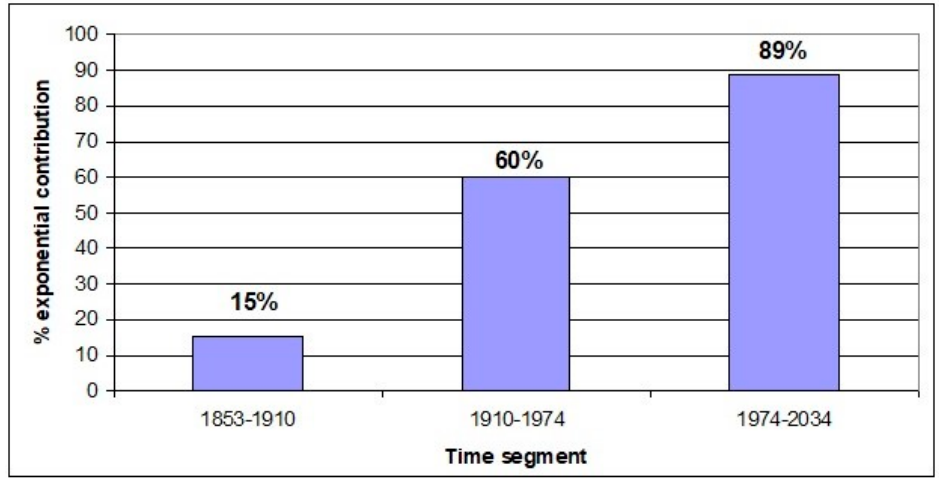
Figure 4. The mean percent contribution of the exponential component to GMST anomalies on the multidecadal scale after removing a ~60-year tidal oscillation.